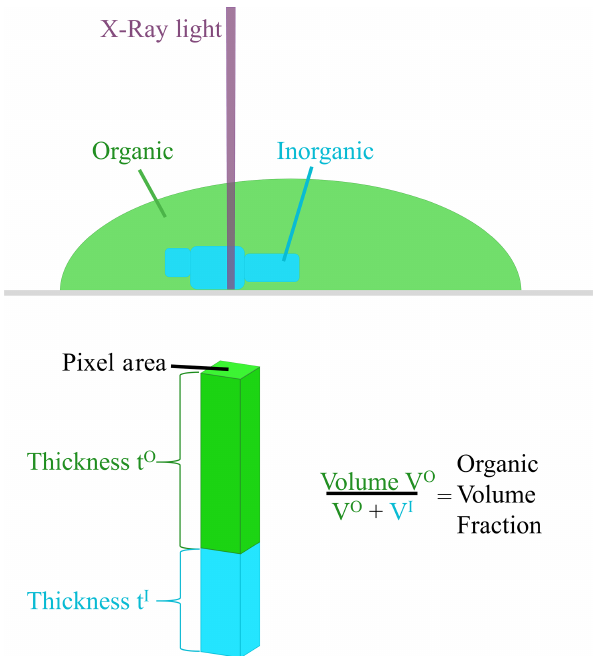
Figure 2. Visual of organic volume fraction (OVF) calculation with 2µm particle and 30nm spot